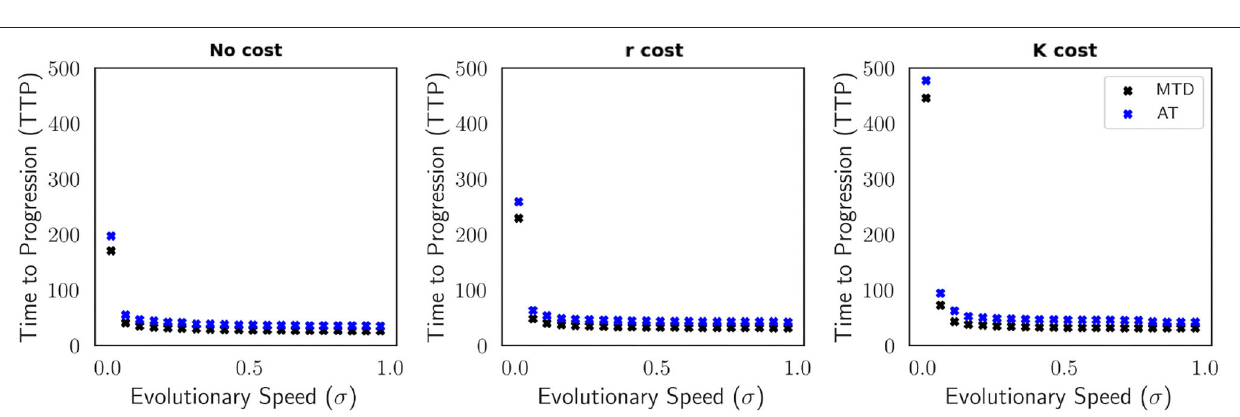
FIGURE 4 | TTP for MTD (black) and AT (blue) as a function of the evolutionary speed for a polymorphic tumor cell population. This is illustrated for each model of cost of resistance (no cost, r cost, and K cost). At faster speeds of evolution, AT remains favorable but TTP decreases for both AT and MTD. Of the three models of cost of resistance, the TTP for MTD and AT is shortest in the absence of a cost and greatest when the cost of resistance impacts the carrying capacity K . The parameters used in this figure are: m = 1, K max = 10,000, r max = 0.45, k = 2, b = 10, d = 0.01, g = 0.1.